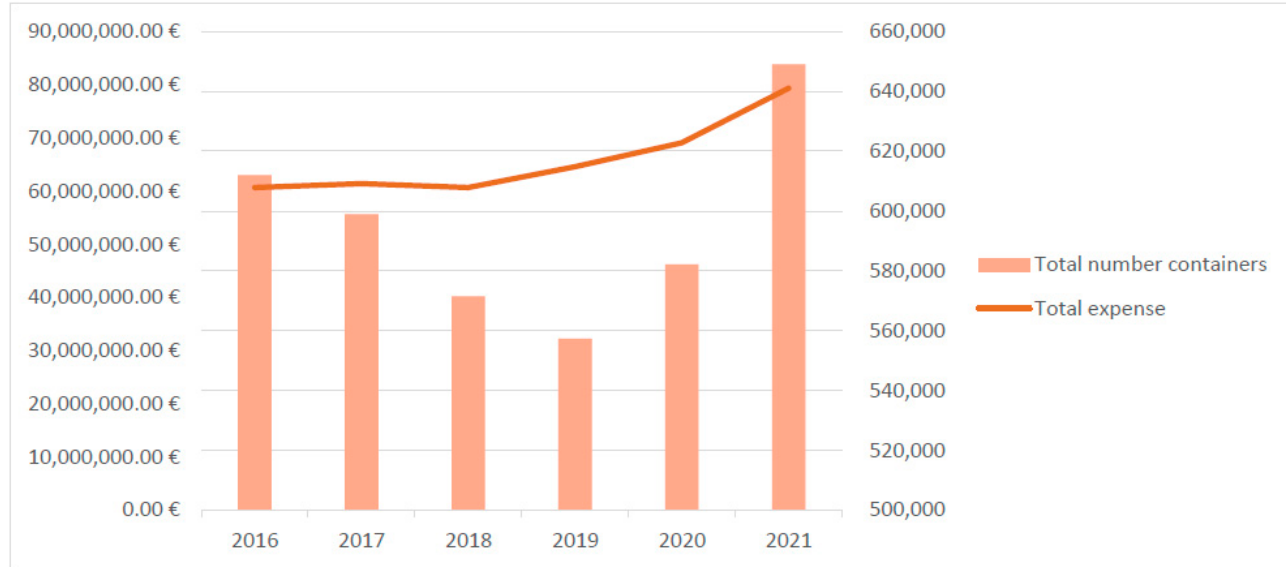
Figure 3. Number of total packs consumed of hyperproteic vs. normal protein (normoproteic) diet therapeutic products from 2016 to 2021 in the Community of Madrid. Table 1 also shows prescription by type of dietary therapy (hyper- or normal protein), as well as calorie and fibre intake in more detail. It is observed that the trend in prescrip- tion has been similar, with a change when the virus started to be noticed, where an in- crease in the prescription of complete oligomeric hyperproteic formulations (almost dou- ble) is observed, with a reduction in the prescription of normoproteic formulations. Like- wise has happened with hyperproteic hypercaloric polymeric complete formulations with and without fibre, as well as with hypercaloric normoproteic complete formulations with